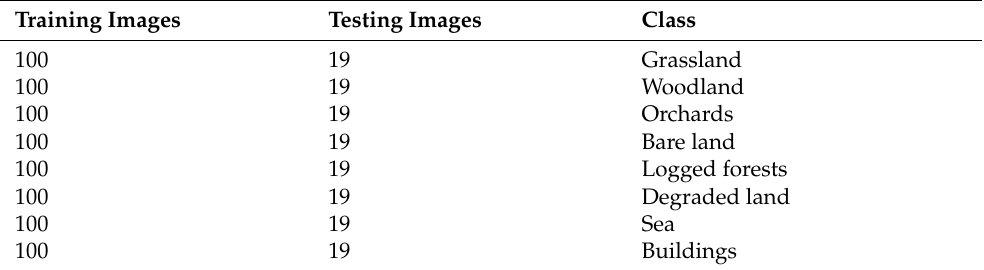
Table 1. Forest type image dataset distribution.